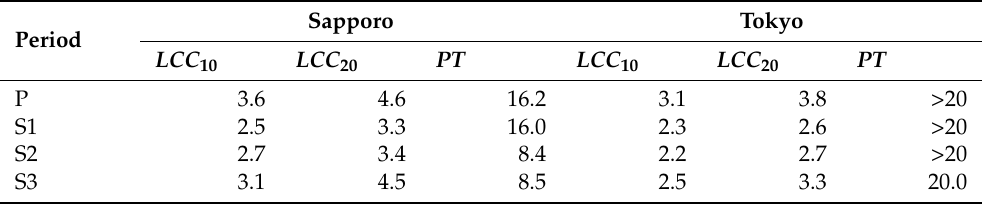
Figure 13. LCC estimates for a residential GSHP system (straight lines) and comparative systems (broken lines) in Tokyo (red) and Sapporo (blue) in the present (P) and future scenarios S1, S2, and S3. Table 3. Summary of estimated LCC after the 10 and 20 years, LCC 10 and LCC 20 [ × 10 6 JPY] and the simple payback time PT [years] in different scenarios of climate change in Sapporo and Tokyo.